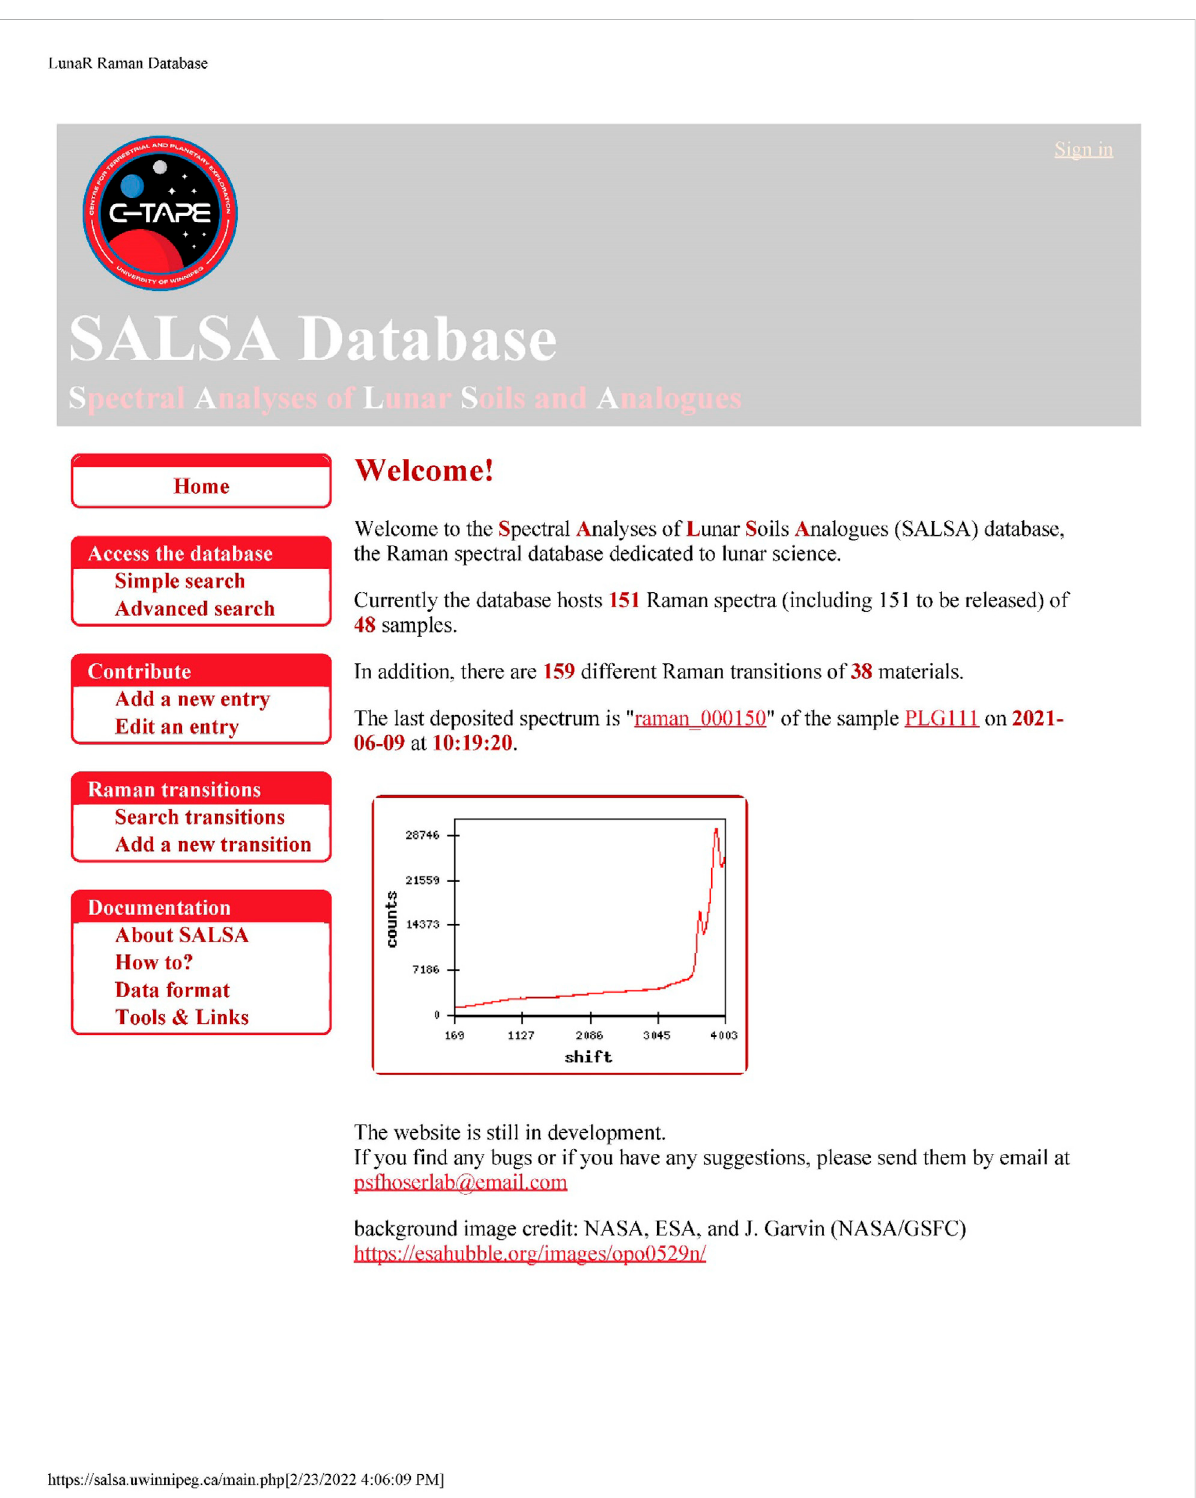
FIGURE 2 Screen shotof thehomepage oftheSpectral AnalysisofLunar Soilsand Analogues databasededicated to theLunaR Raman data (https://salsa.